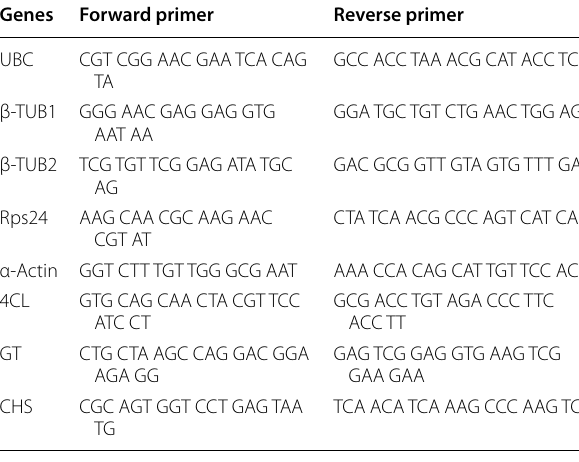
Table 1 Primers used in gene expression analysis Genes Forward primer Reverse